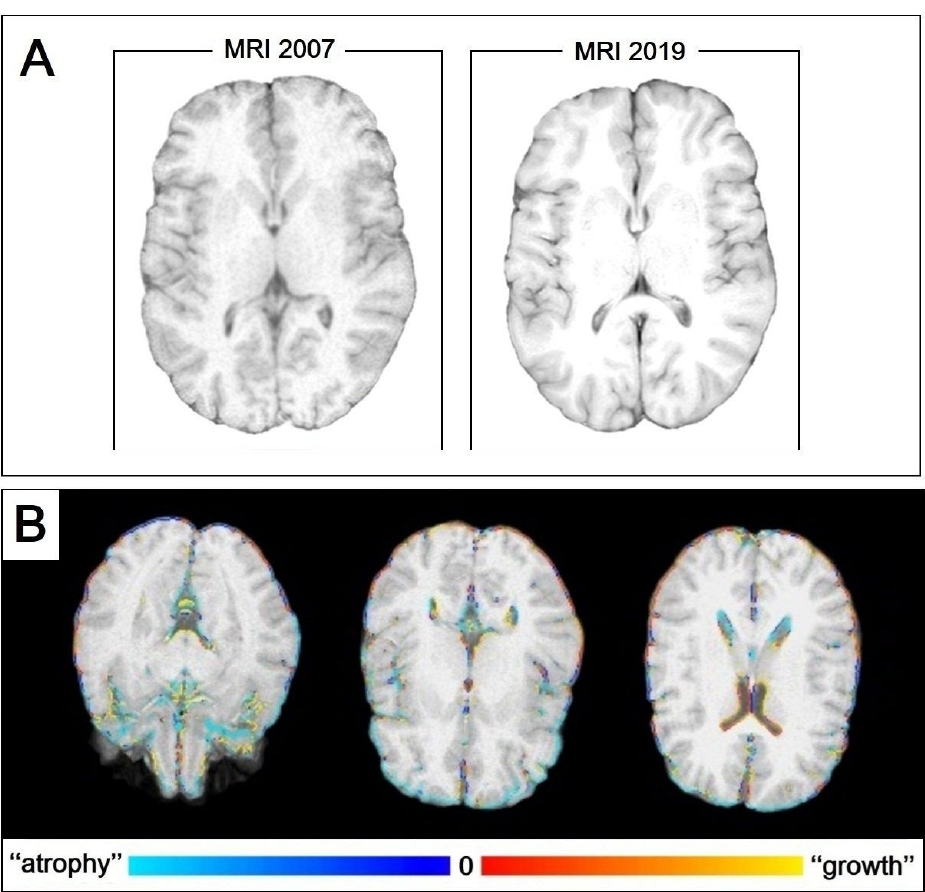
Figure 2. MRI post-analysis. ( A ) T1-weighted axial images of the brain as segmentation output obtained using the Sienax tool. From this comparison of the 2007 and 2019 MRIs, note the structures that most contribute to brain atrophy are the periencephalic liquoral spaces (with a reduction of grey matter and its peripheral fraction). ( B ) Siena color-coded image output of the brain. Blue indicates atrophy; red indicates growth. Note the prevalence of blue in the grey matter, mainly in the peripheral grey matter as well as the ventricular system.